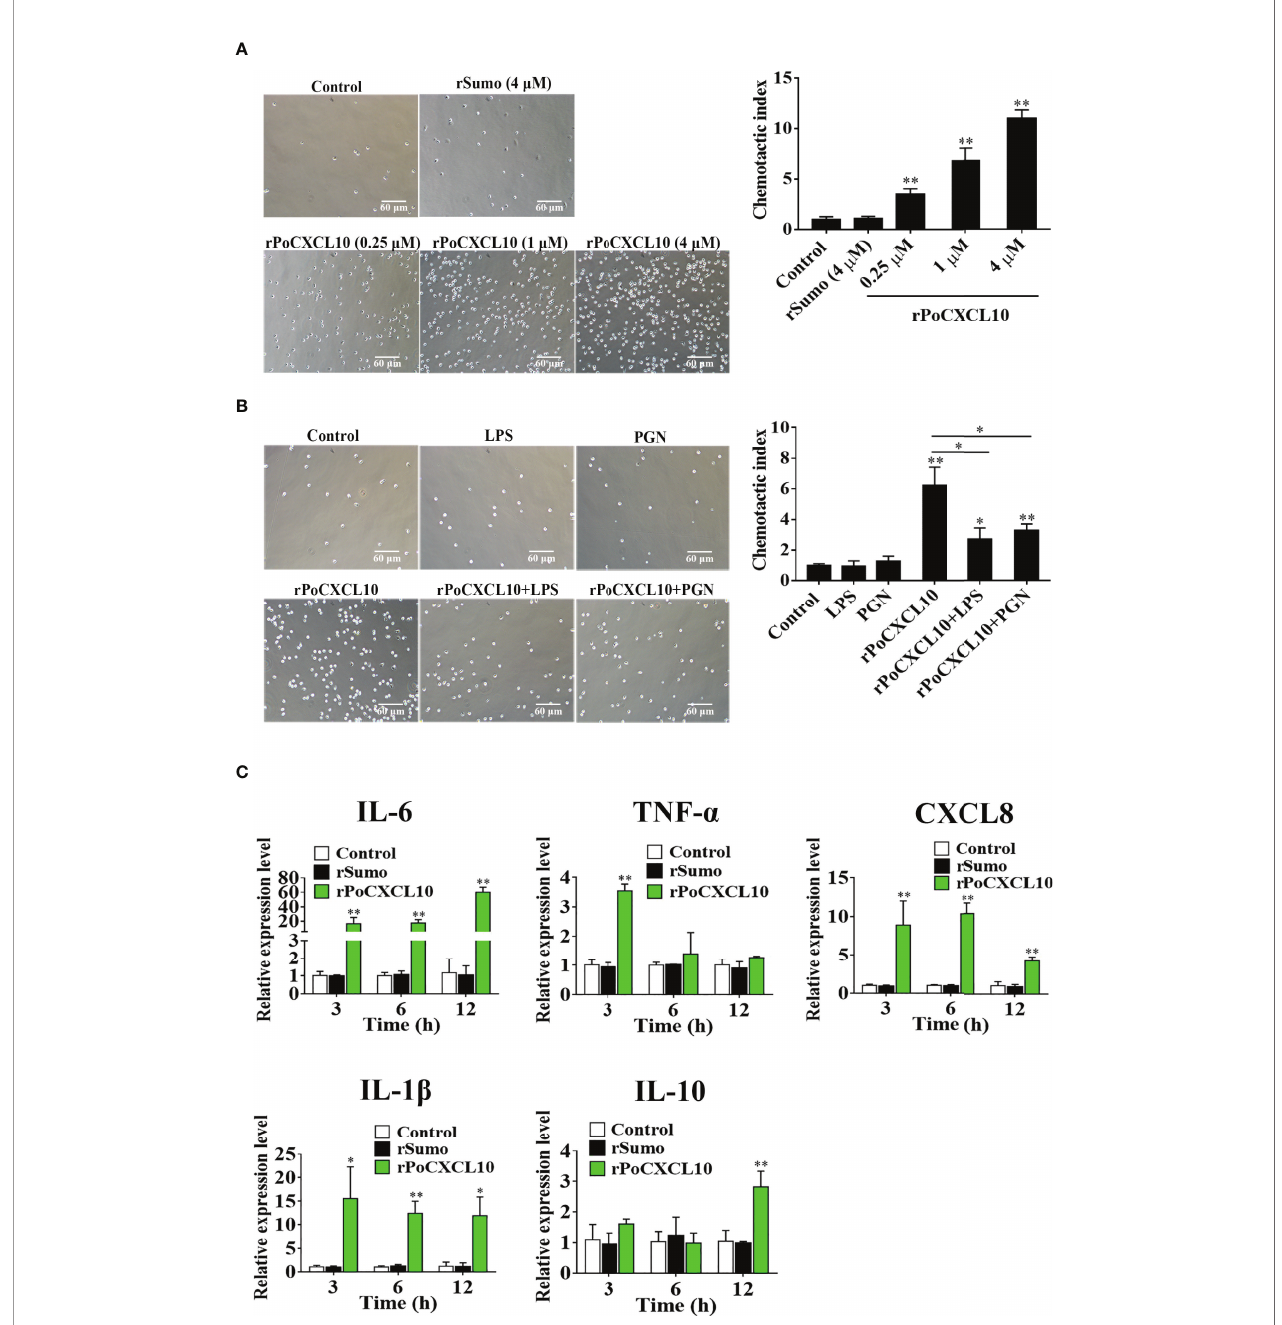
FIGURE 5 | The effect of rPoCXCL10 on the migration and gene expression of fl ounder peripheral blood leukocytes (PBLs). (A) Flounder PBLs were treated with different concentrations of rPoCXCL10 or rSumo or PBS (control). Migration of the cells was determined by the Transwell migration assay. Bar size, 20 m m. Chemotactic index was presented as the ratio of the number of migrated cells induced by rPoCXCL10 or rSumo to that induced by PBS. (B) Flounder PBLs were incubated with or without (control) LPS, PGN, rPoCXCL10, or LPS/PGN-pretreated rPoCXCL10. Cell migration was then determined as above. The chemotactic index is shown in the graph. Bar size, 20 m m. (C) Flounder PBLs were treated with or without (control) rPoCXCL10 or rSumo for different hours, and the expression of in fl ammatory cytokines was determined by qRT-PCR. For all panels, values are the means of triplicate experiments and shown as means ± SD. * P < 0.05; ** P <